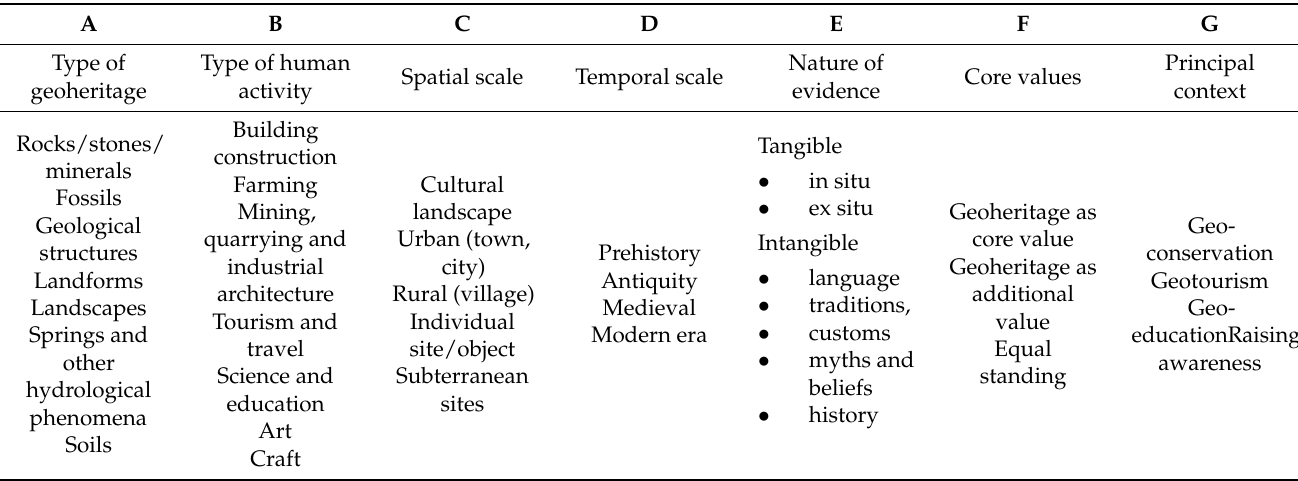
Table 1. Various approaches (A–G) with their underlying factors important to classification of themes at the geoheritage—cultural heritage